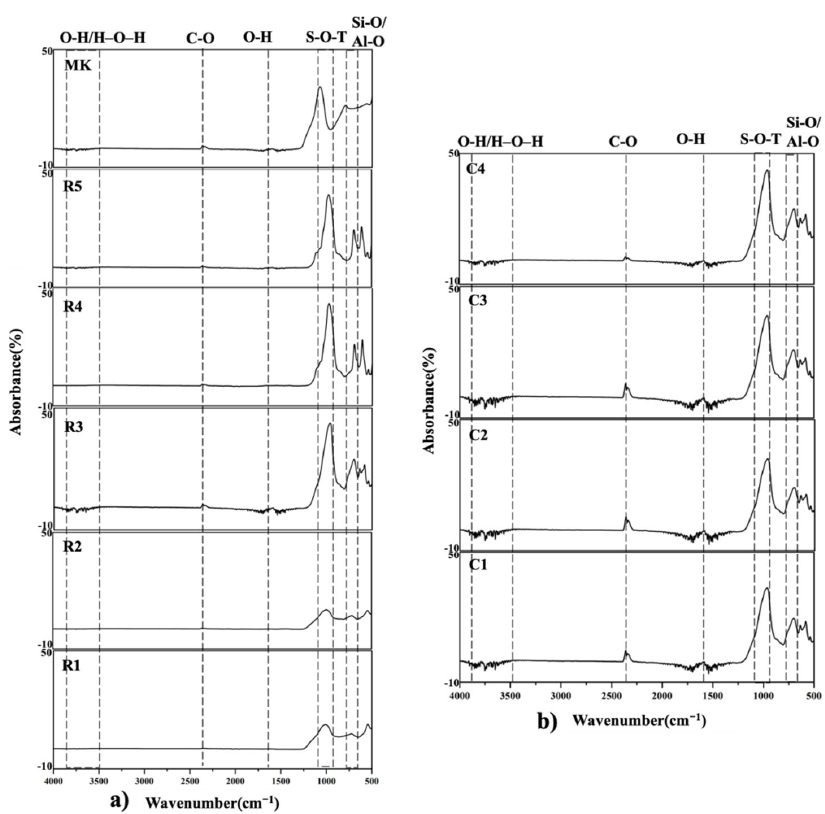
Figure 3. FTIR analysis of KGL prepared with different ( a ) alkaline solution ratios and ( b ) curing times.